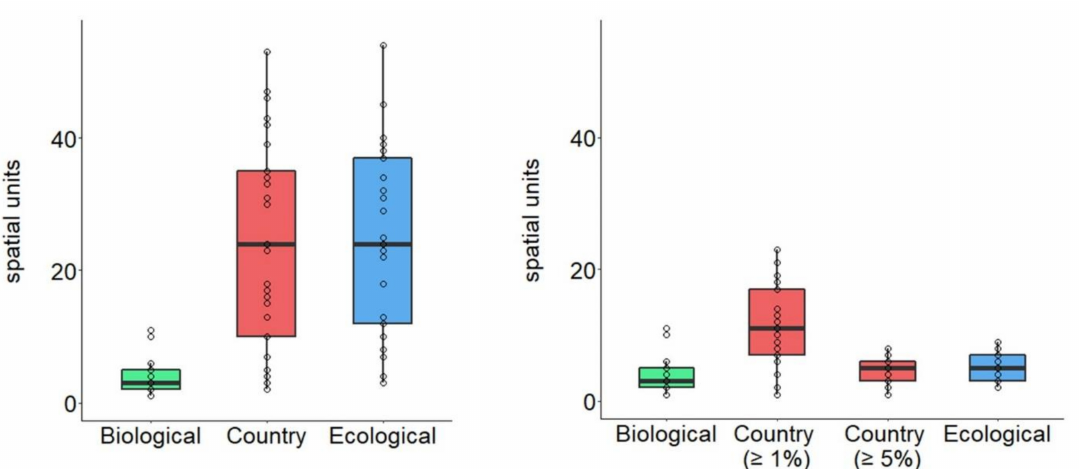
Figure 1. Boxplots showing the number of spatial units generated for 29 species of European mammals and birds using different methods of dividing the baseline distribution into spatial units. Center bars show median values. ( Left ): Number of spatial units resulting from biologically based delineation methods compared with fine alternative spatial unit delineation methods (all countries within the baseline distribution treated as a separate spatial unit and ecological spatial units based on ecoregions). ( Right ): Number of spatial units resulting from biologically based delineation methods compared with coarser alternative spatial unit delineation methods (only countries comprising ≥ 1% or ≥ 5% of the baseline distribution area treated as spatial units, and ecological spatial units based on